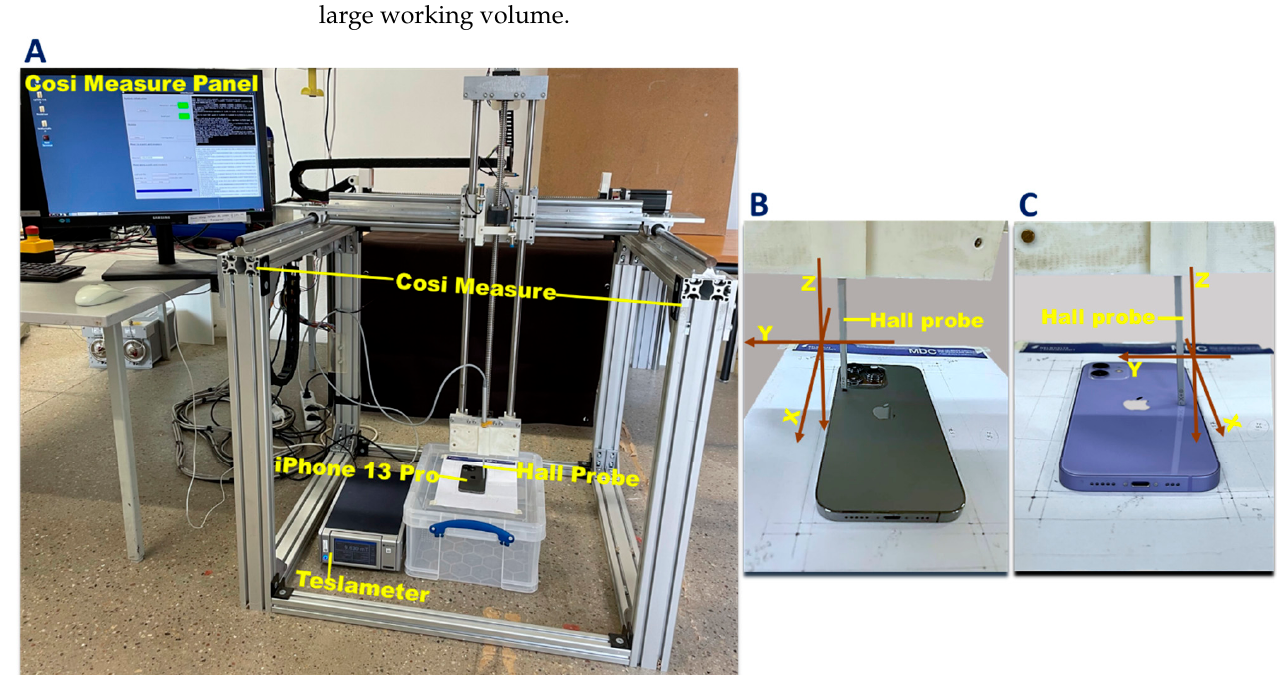
Figure 1. Setup used for mapping the static stray magnetic field of the iPhone 13 Pro, the iPhone 12, and the MagSafe wireless charger. A : For measuring the stray magnetic field of the target device a three-axis Hall probe (FP-2X-250-ZS15, Lake Shore Cryotronics, Westerville, OH, USA) was connected to a teslameter (Model F71, Lake Shore Cryotronics, Westerville, OH, USA). For spatial mapping of the stray magnetic field, COSI Measure was used to control the sample trajectory of the Hall probe ( A ). B , C : The Hall probe was placed perpendicular to the plane of the iPhone 13 Pro ( B ) and iPhone 12 ( C ).